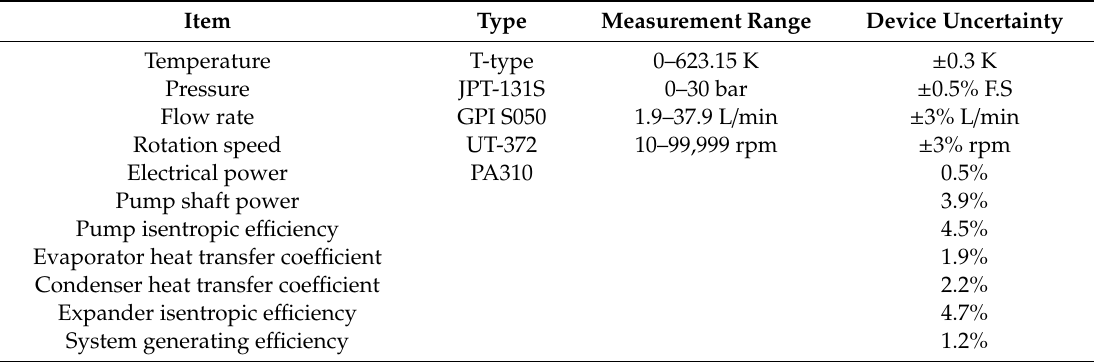
Table 4. The measuring devices and the uncertainties for system parameters.